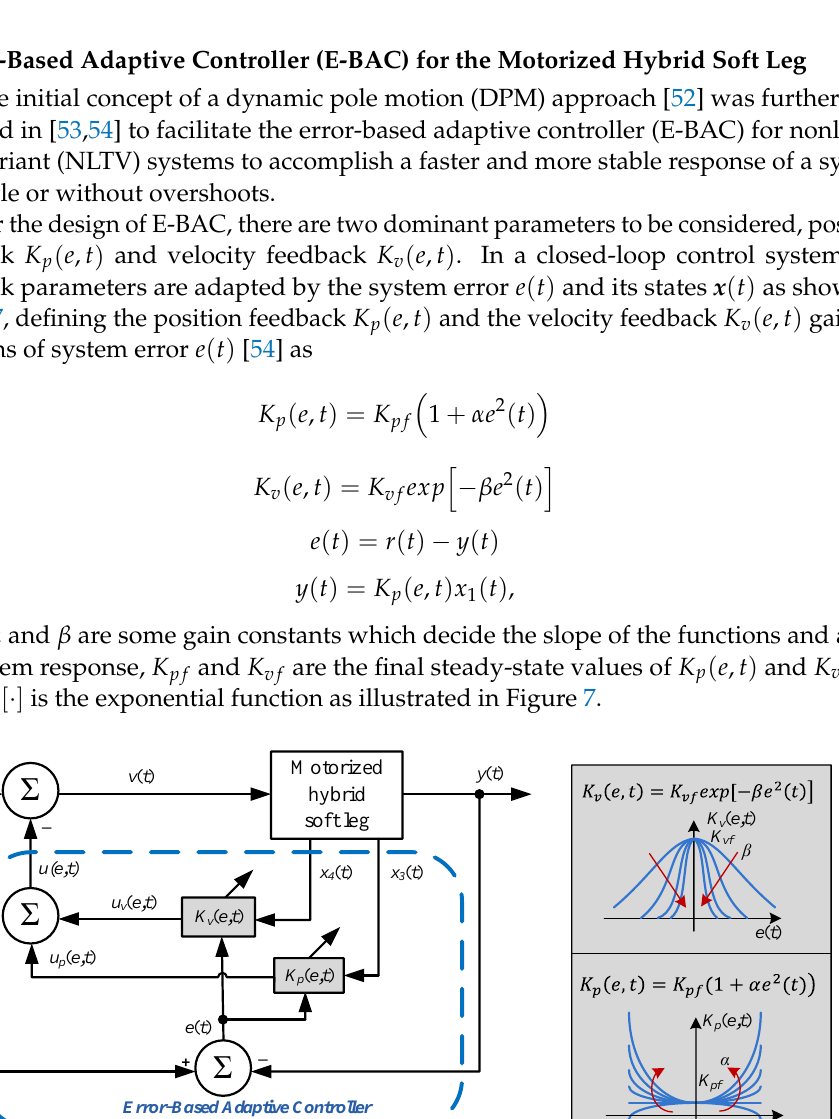
Figure 7. Schematics of an error-based adaptive controller (E-BAC): 𝑥 4 (𝑡) = 𝑥̇ 3 (𝑡) , and the change of the slopes of 𝐾 𝑝 (𝑒,𝑡) and 𝐾 𝑣 (𝑒, 𝑡) curves. For various values of α and β, the directions of the arrows indicate the increasing values of 𝛼 and 𝛽 .